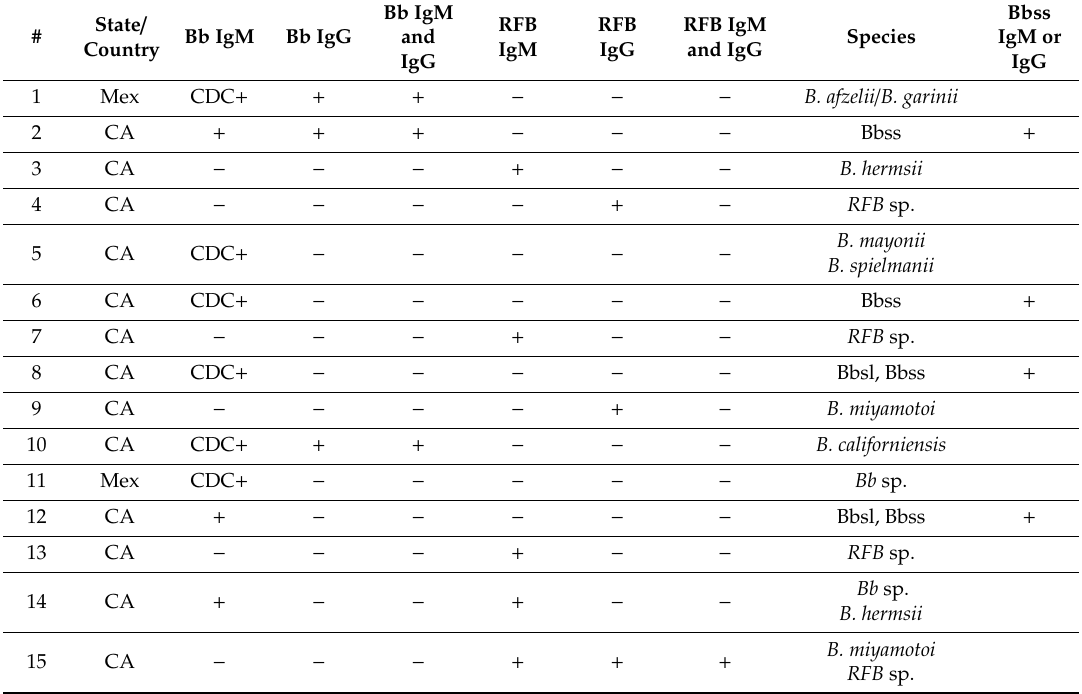
Figure A2. Immunoblot reactivity for Relapsing Fever Borrelia (RFB). Immunoblot strips with recombinant Borrelia antigens were incubated with representative patient serum samples, as described in Section 2. P—positive control; N—negative control; G—RFB immunoblot IgG; M—RFB immunoblot IgM; 1— B. hermsii positive IgM; 2— B. turicatae positive IgG; 3— B. miyamotoi positive IgM; Table A1. Test results of study subjects showing place of residence, species of Borrelia seroreactivity, and IgM/IgG reactivity. CDC+, positive by CDC recommended surveillance criteria; +, positive by IGeneX in-house criteria; − , negative; IND, indeterminate.